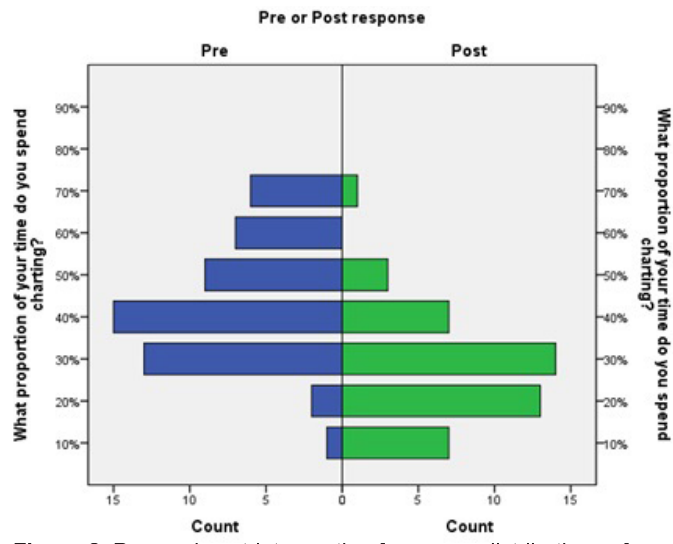
Figure 2. Pre- and post-intervention frequency distributions of reported proportion of shift time spent charting.